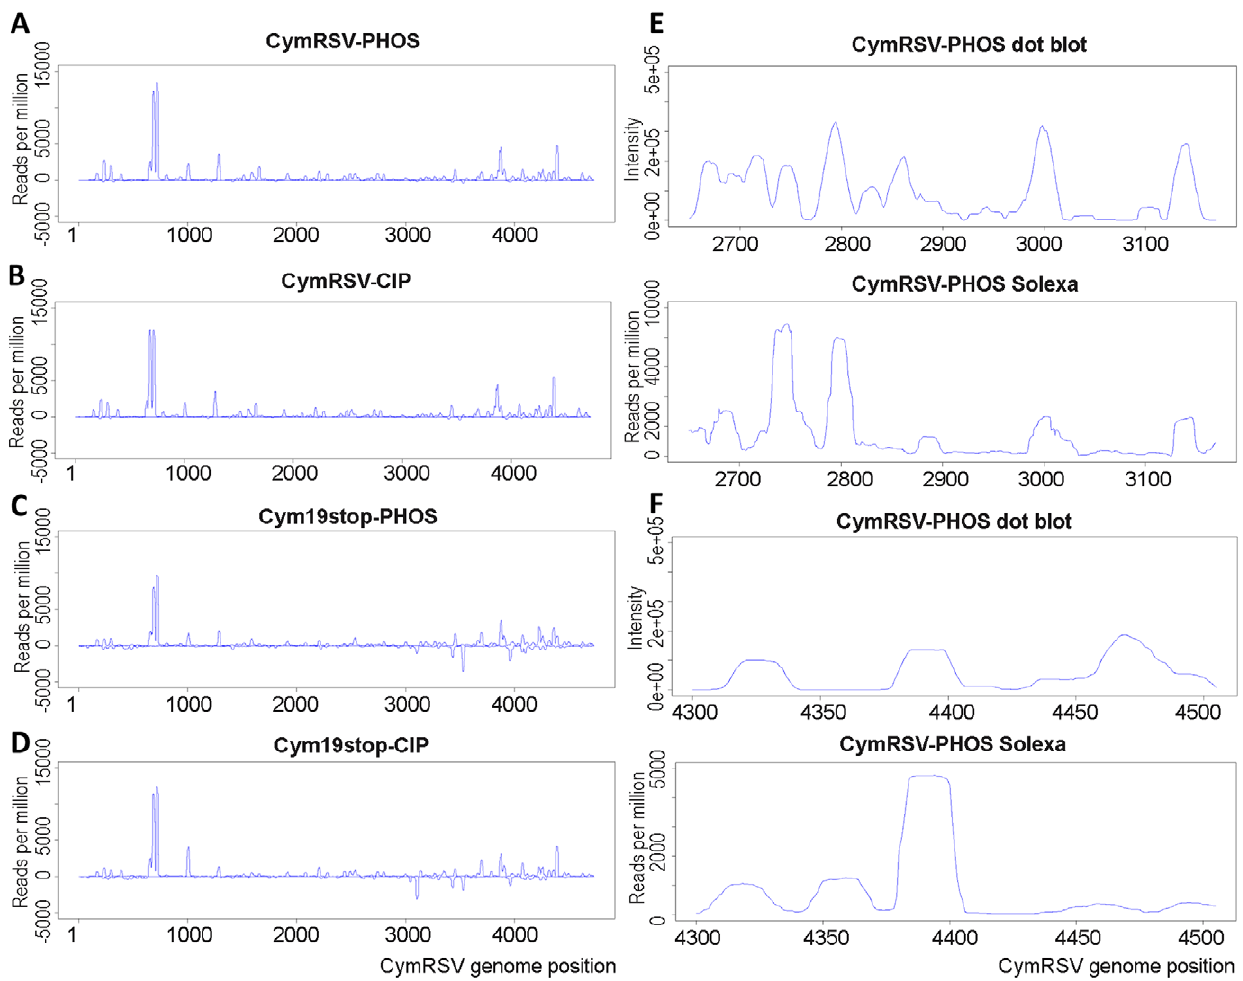
Figure 4. Solexa and dot plot profiles of vsiRNAs. vsiRNA sequences obtained by Solexa sequencing were mapped to the CymRSV genome and normalised abundances were plotted for each sample (A–D). Short RNAs were sequenced from wild type (CymRSV) or silencing protein disabled (Cym19stop) in vitro transcript infected N. benthamiana following two different protocols. The 5 9 adapter was either directly ligated to the short RNAs (PHOS) or first depohosphorylated and then re-phosphorylated before adapter ligation (CIP). Profiles obtained by dot blot and Solexa sequencing were compared for regions 2650–3169 (E) and 4300–4505 (F). Please note that the dot blot profiles are the same as those shown in Figure 1E and H.